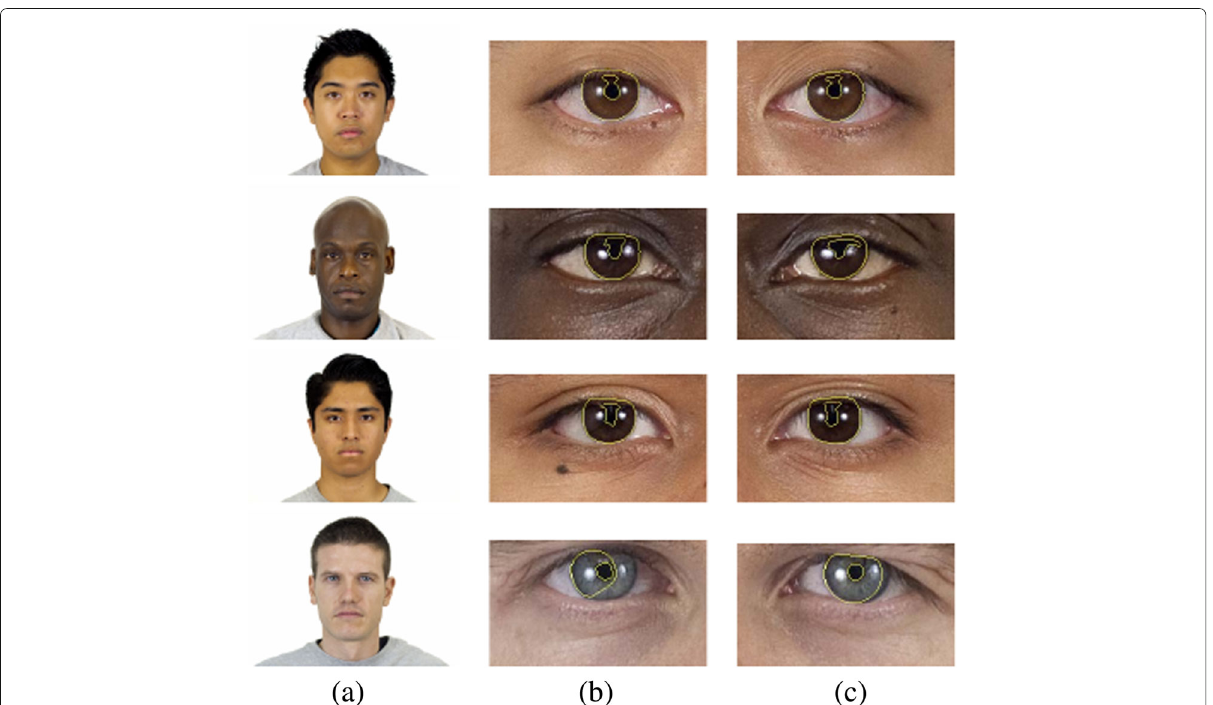
Fig. 9 Some examples of incorrect iris segmentation. Rows: Asian, Black, Latino and White ethnicity, respectively. Original face ( a ), right iris segmentation ( b ) and left iris segmentation ( c )